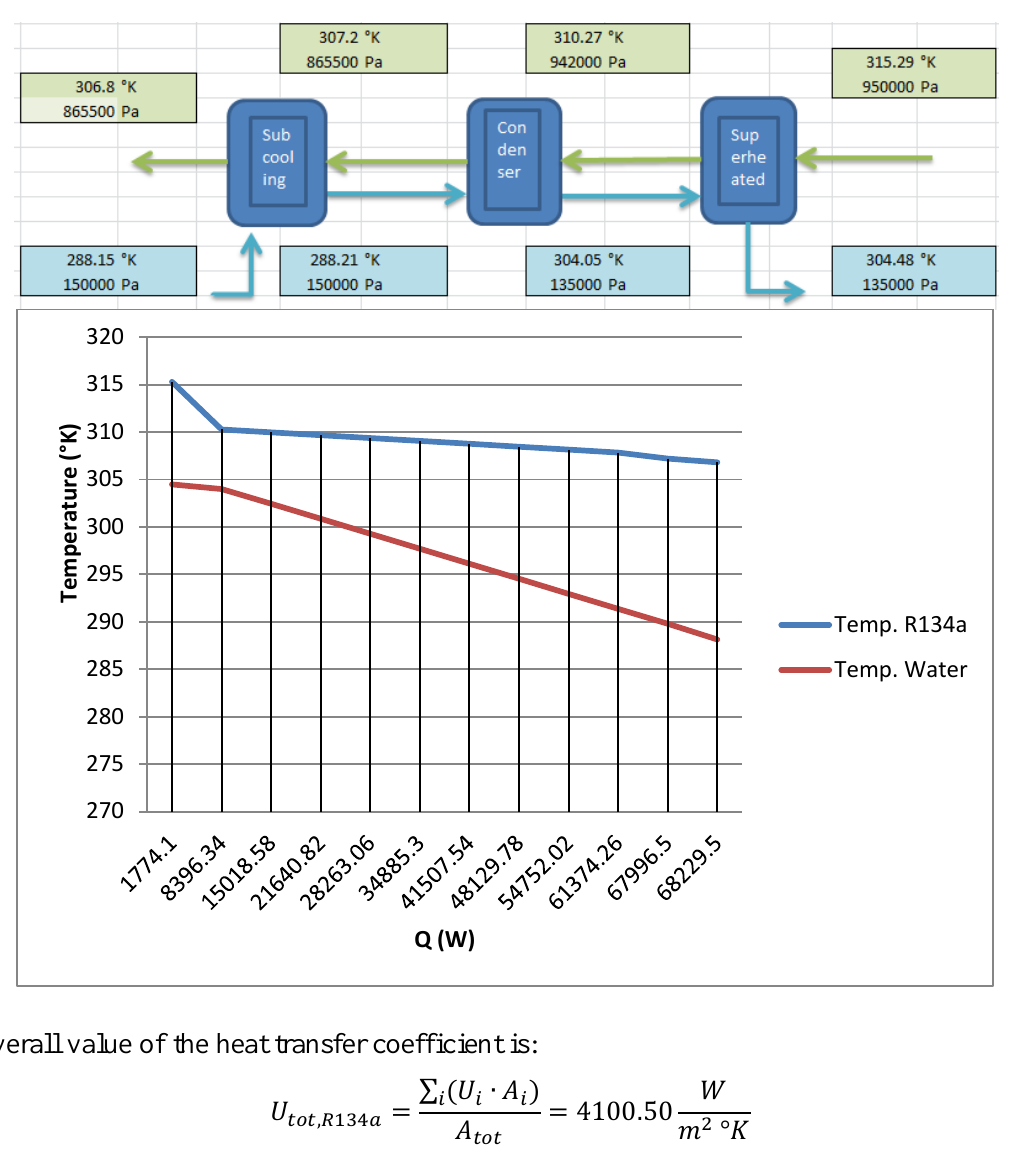
Figure 5. R134a thermal